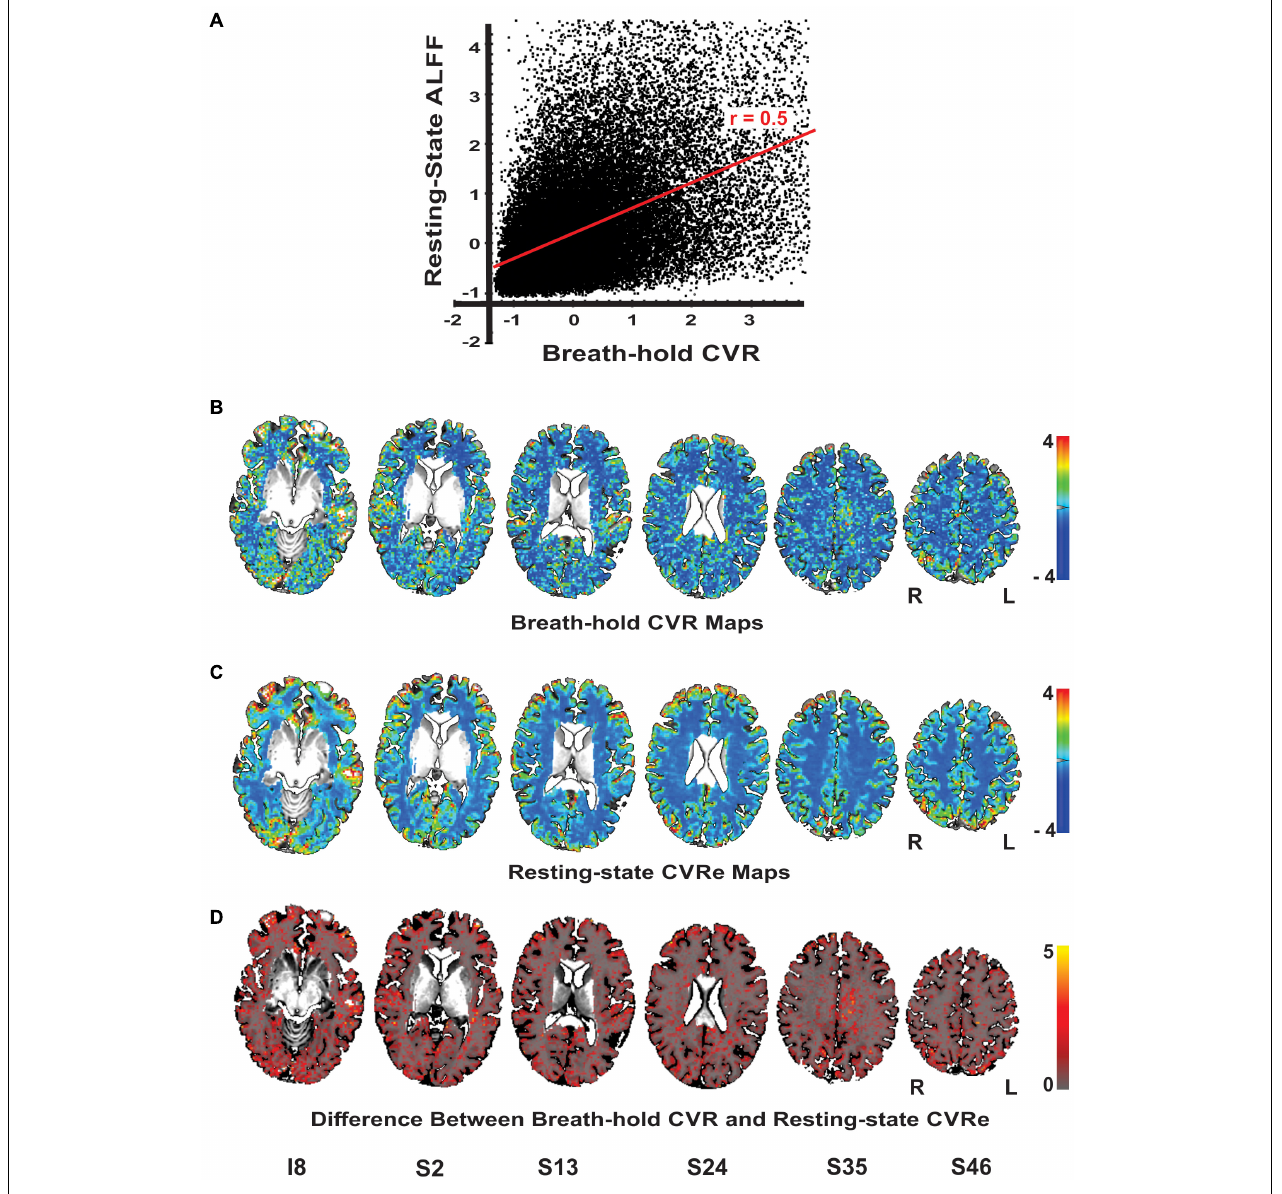
FIGURE 4 | (A) Scatterplot of the unthreshold resting-state and breath-hold CVR metrics for a representative subject. Each point represents one voxel in the cortical gray matter. Full range of data has been clipped to 95% of voxels. The two metrics are correlated with a correlation coefficient of 0.50. (B–D) Axial brain images with overlaid unthresholded maps of breath-hold CVR (B) , resting-state CVRe (C) , and difference metric (D) . Voxel color code indicated at right. Labels under slice images indicate relative slice position in mm (I, inferior; S, superior). Slice right/left (R/L) orientation is radiologic